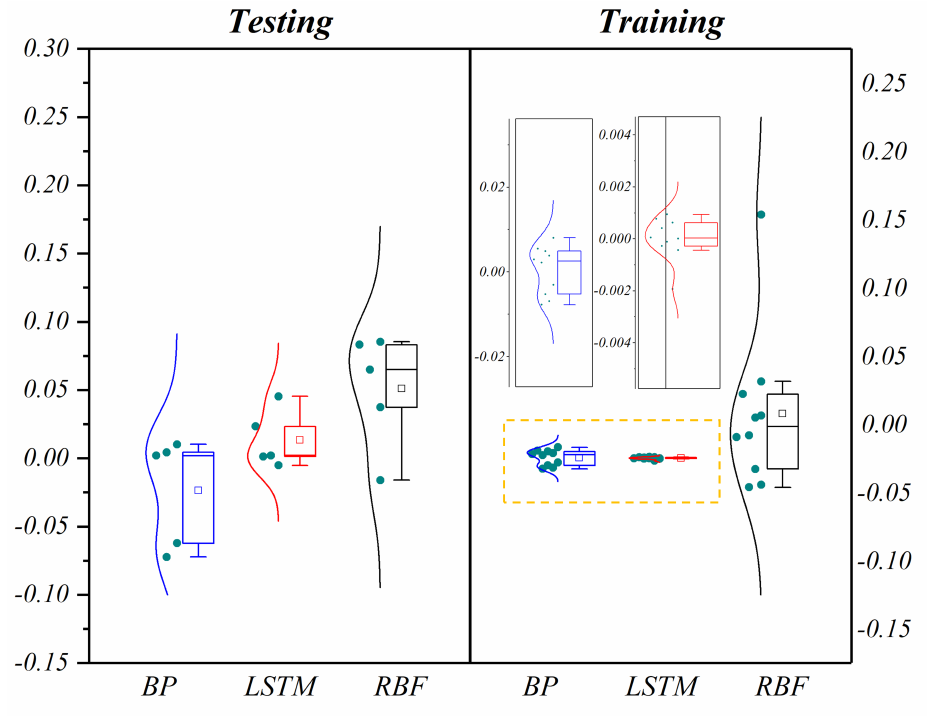
Figure 7. Evaluation score results histogram: absolute error score results